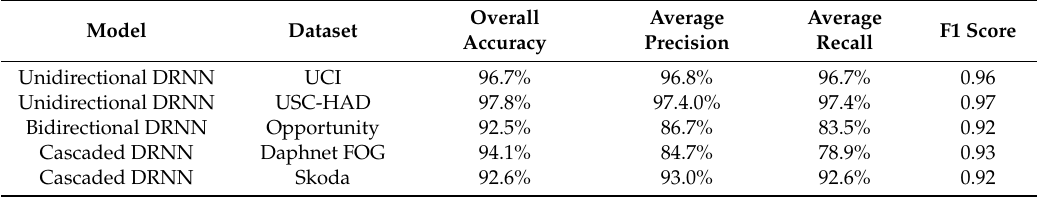
Table 2. Performance summary for the proposed DRNNs on four diverse